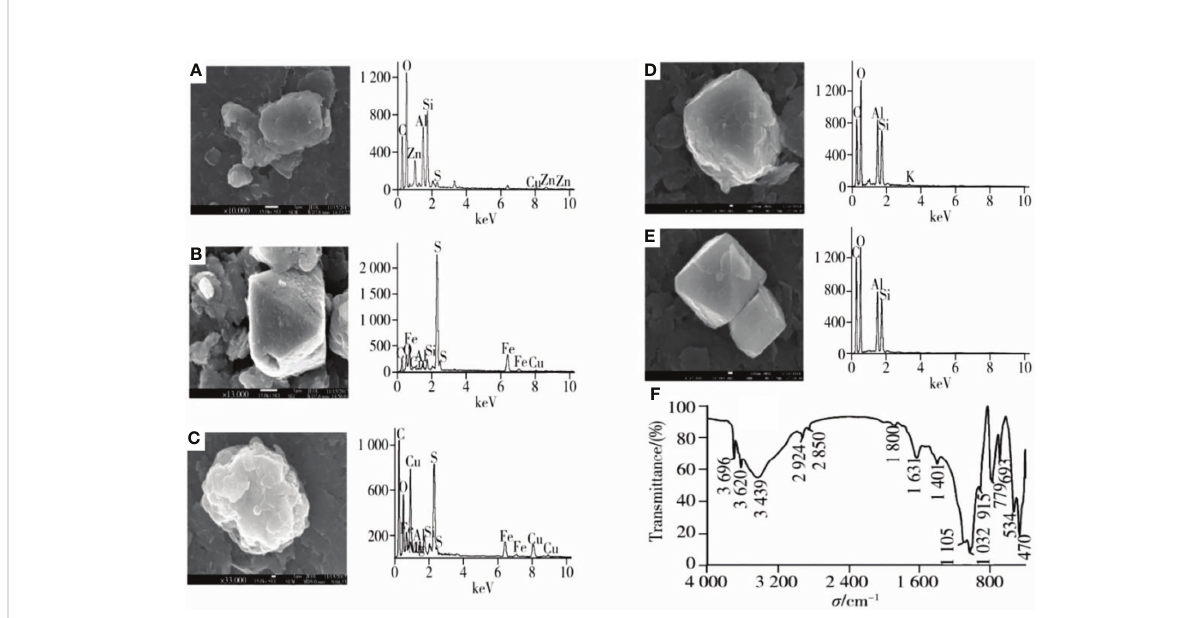
FIGURE 8 SEM images and its EDS pro fi les of mangrove sediments (A-C) and bare beach sediments (D-E) , as well as FTIR pro fi les of mangrove sediments (F)